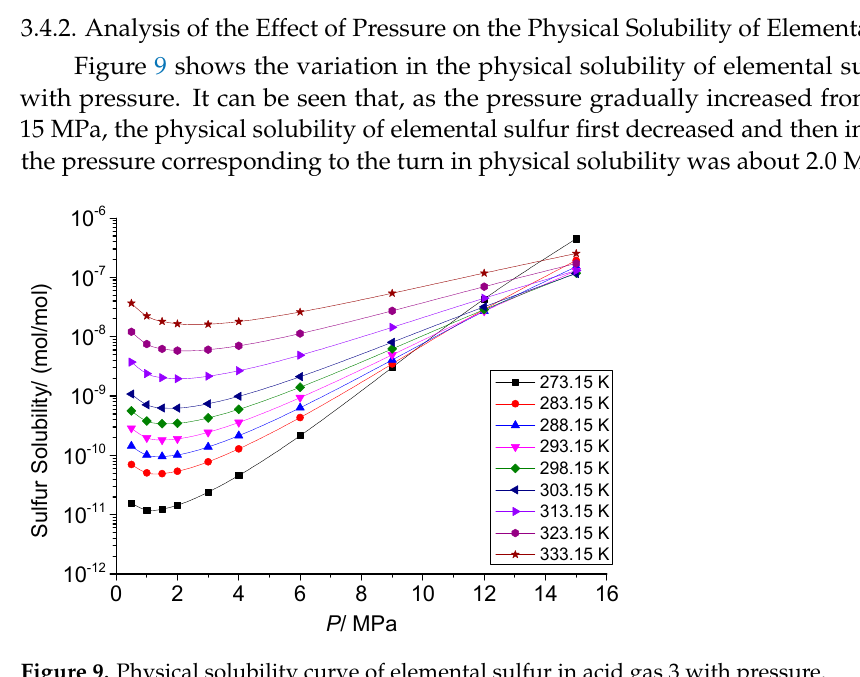
Figure 9. Physical solubility curve of elemental sulfur in acid gas 3 with pressure.